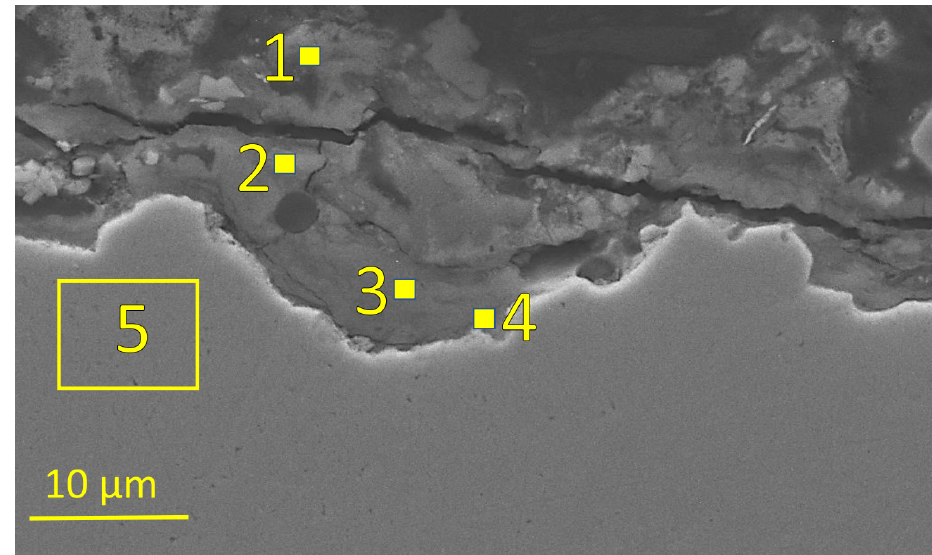
Figure 7. Cross-section of tested carbon-steel sample 1 one cm from the inlet of the first reactor. A continuous oxide layer was observed. Table 8. Elemental analysis from locations in Figure 7.